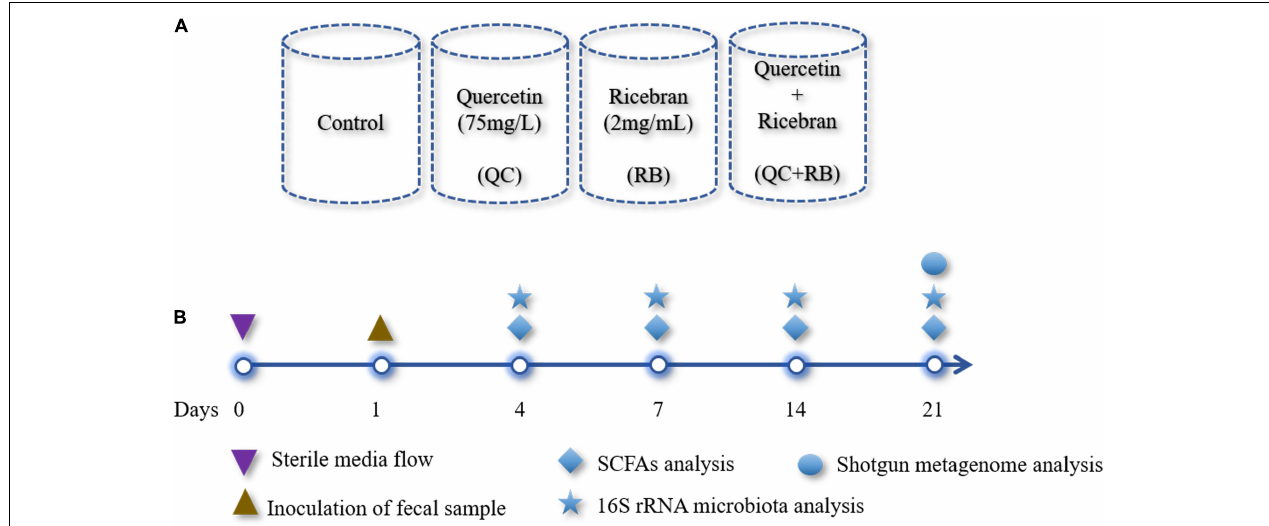
FIGURE 1 | Overview of the study design: (A) A schematic diagram shown the design of four different media conditions used in this study. Single substrates (quercetin or rice bran) or the mixture of quercetin and rice bran were used at the final concentration of 75 and 2 mg/mL as shown above in the base medium BHI (see section “Materials and Methods”). Final pH of the media was adjusted to 6.8 ± 0.2 for all conditions. Each condition was run in triplicate and were inoculated with the same fecal inoculum (see section “Materials and Methods”). (B) Outline of the bioreactor experiment showing time points for fecal inoculation and sample collection for SCFAs and microbial community